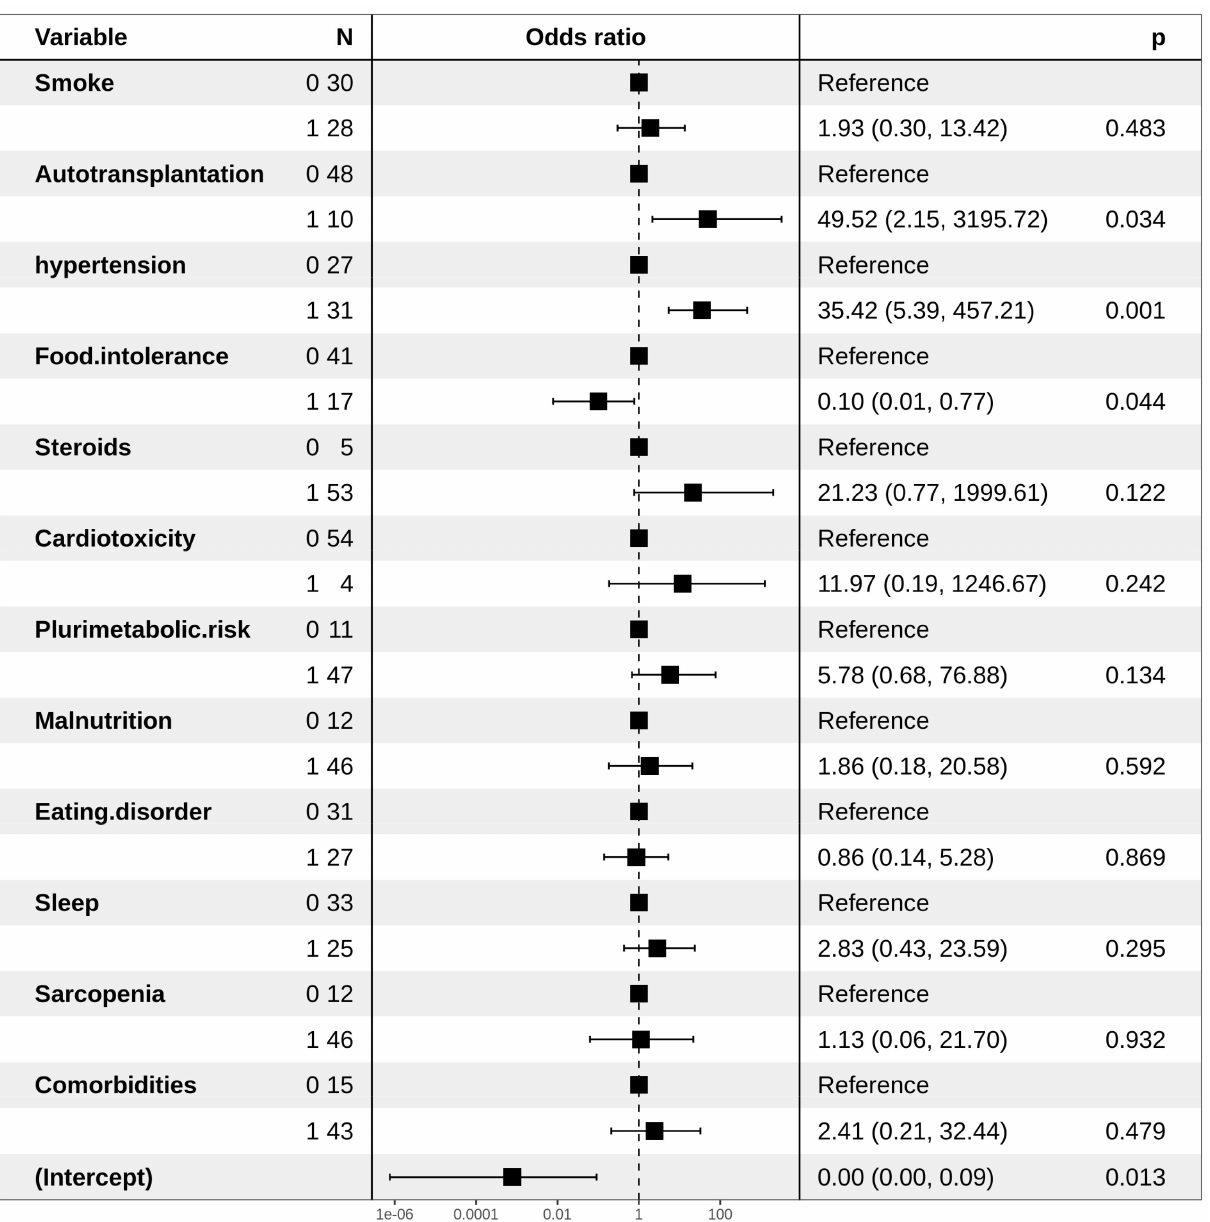
Figure 1. Forest plot representing multivariate logistic regression for a